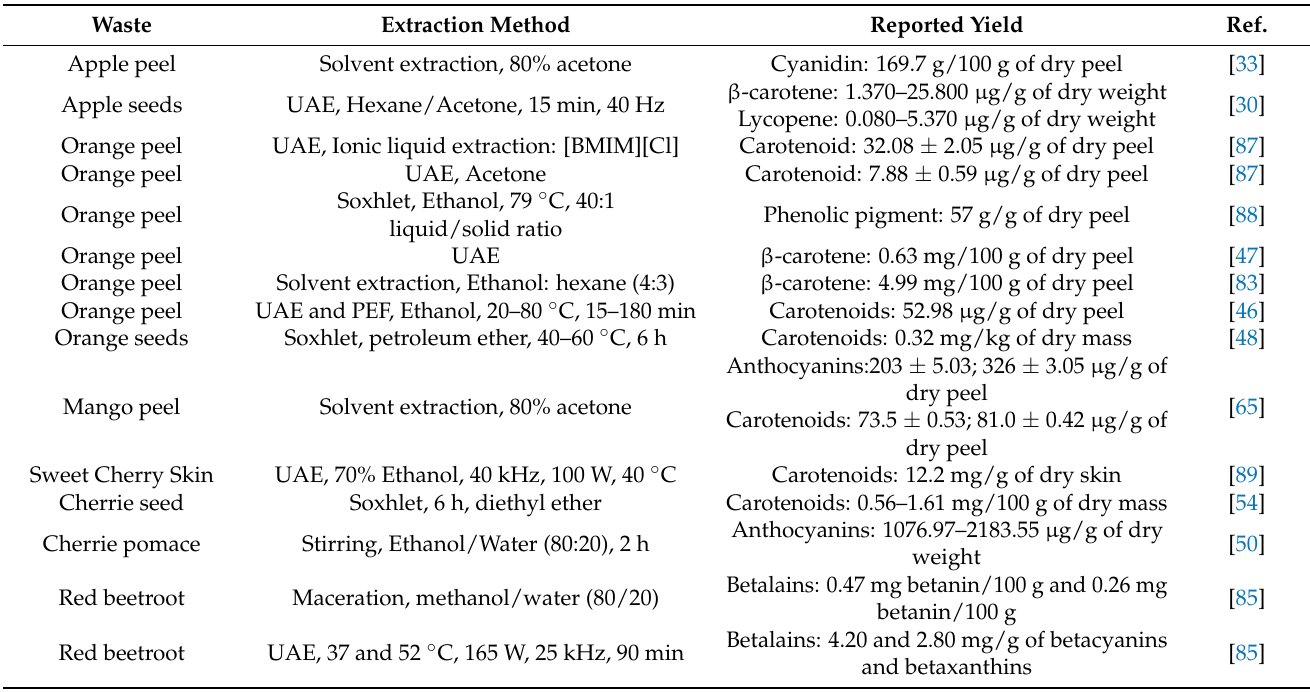
Table 9. Summary of different studies on for the extraction of bioactive pigments from food